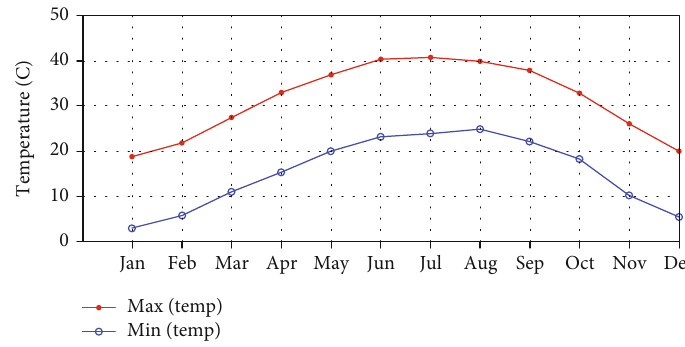
Figure 5: Average monthly temperature variations at Aswan